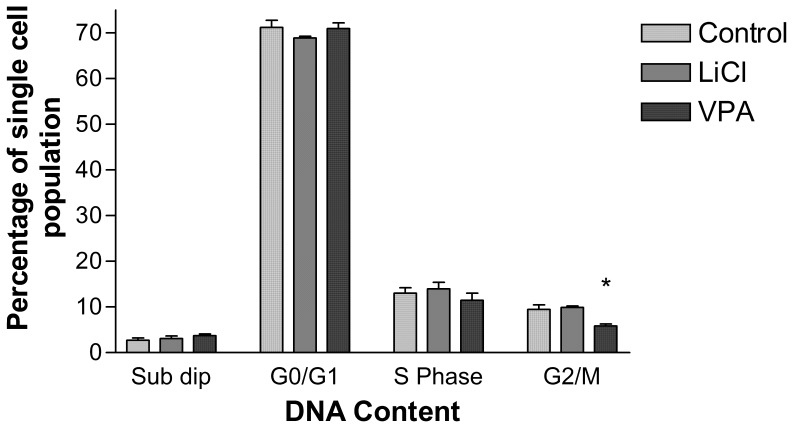
Cell cycle analysis of RA, LiCl+RA and VPA+RA treated cells.Cell populations of dissociated neurospheres in each cell cycle phase post treatment with VPA (0.5 mM) and LiCl (1.0 mM) and total cell number as a percentage of control cells post lithium and VPA treatment results are shown as ± S.E.M (n = 3). p<0.05(*), p<0.01(**), p<0.001(***). p values were calculated by One-way ANOVA and corrected for multiple comparisons by Bonferroni’s multiple comparison post-test in comparison to the RA only control.